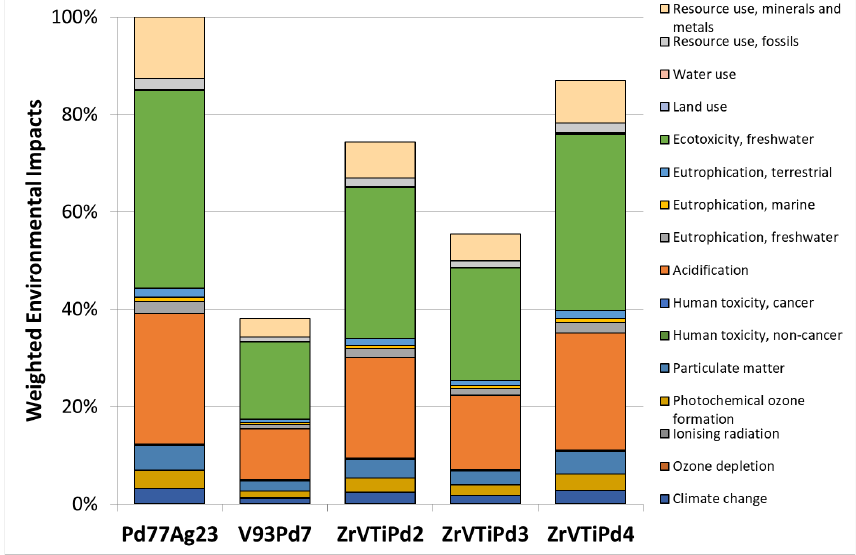
Figure 8. Comparison of weighted environmental impacts of the same mass quantity of different membrane compositions and Pd contents relative to Pd 77 Ag 23 . membrane compositions and Pd contents relative to Pd 77 Ag 23